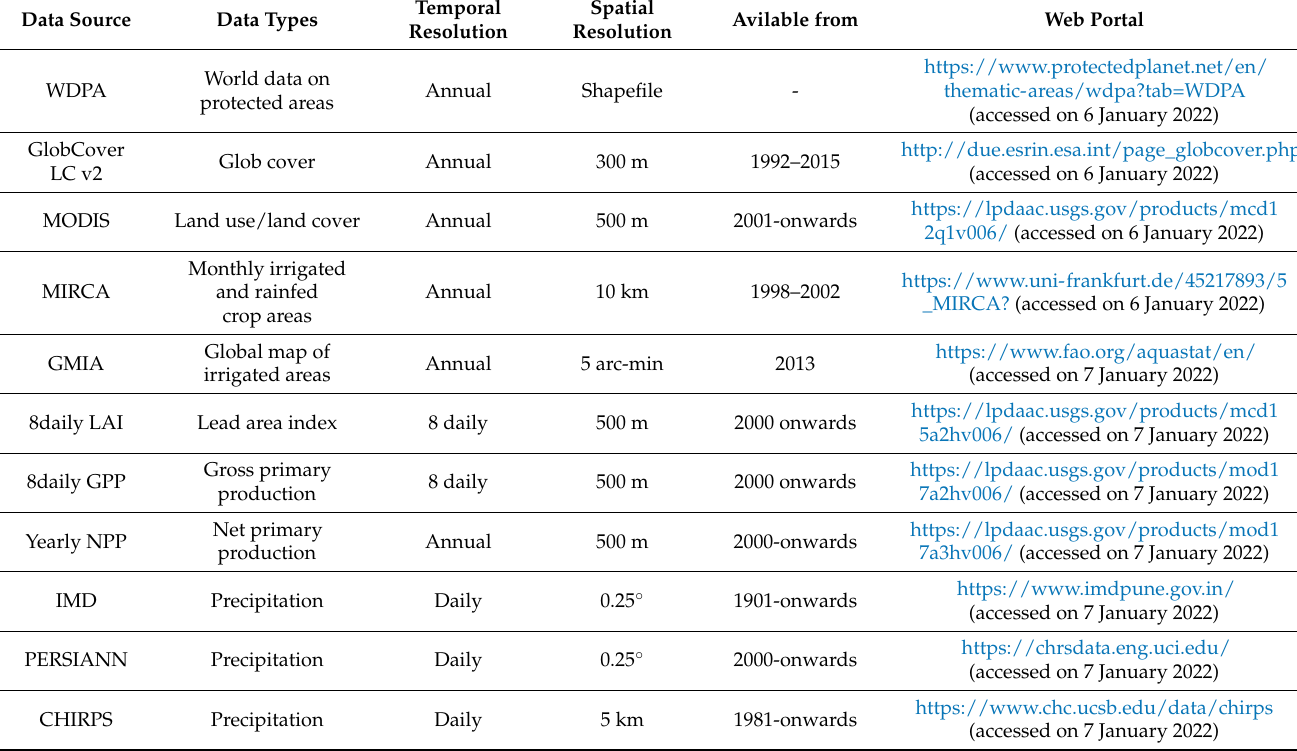
Table 1. List of earth observation datasets used for estimating total water consumption in